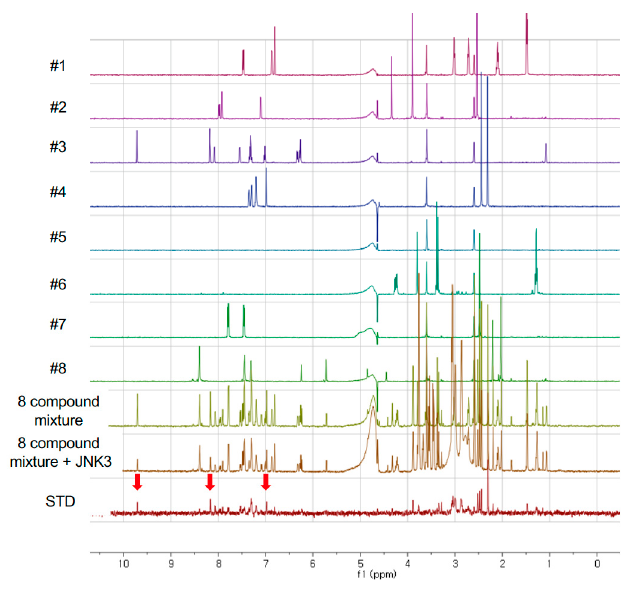
Figure 1. Reference NMR spectra of fragments and STD NMR spectrum. The spectra from #1 to #8 were the individual spectrum of fragment in a single NMR tube, respectively. STD NMR spectrum showed that compound #3 might bind to JNK3 (indicated by red arrow).